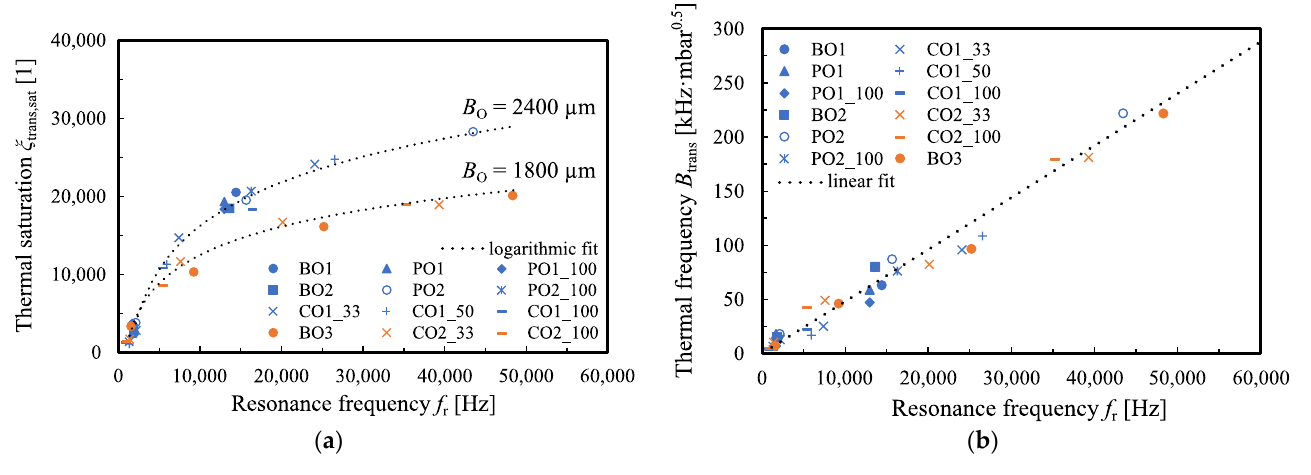
Figure 8. Saturation values of the thermodynamic damping for large gap widths determined ac- cording to Equation (10) ( a ). The data of the MEMS oscillators show a good agreement with a logarithmic function. The graph reveals two groups that differ in the width of the oscillators B O . The thermodynamic resonance frequency is determined by the fit parameter B dyn which shows an almost linear trend to the resonance frequency of the oscillator ( b ).